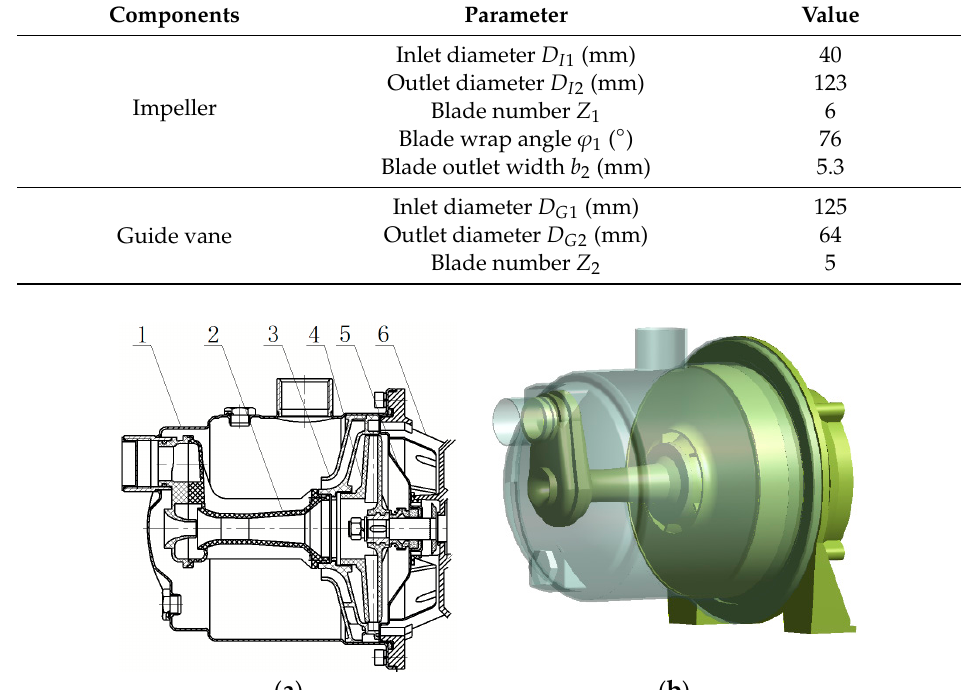
Table 1. Parameters for the model jet centrifugal pump.